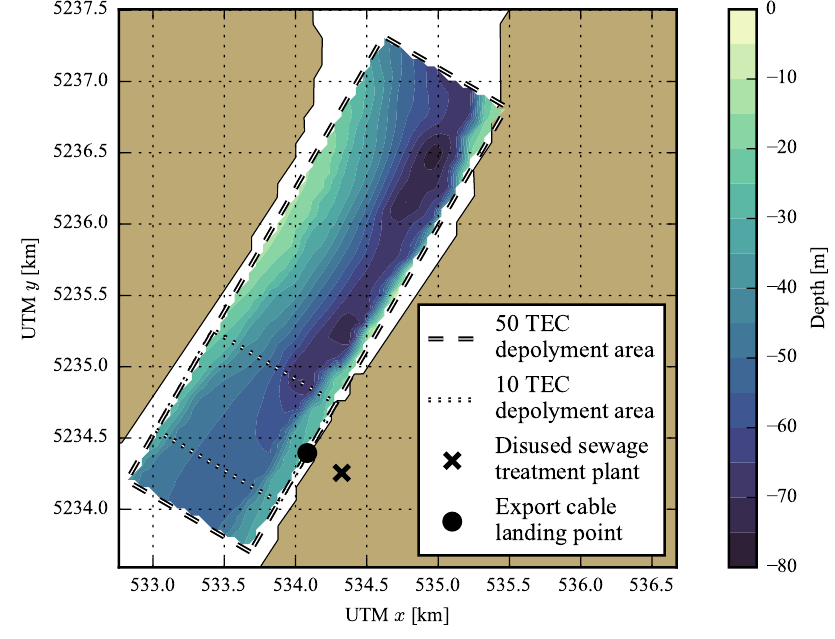
Figure 8. Bathymetry, deployment area extents and energy export infrastructure for the Tacoma Narrows DTOcean